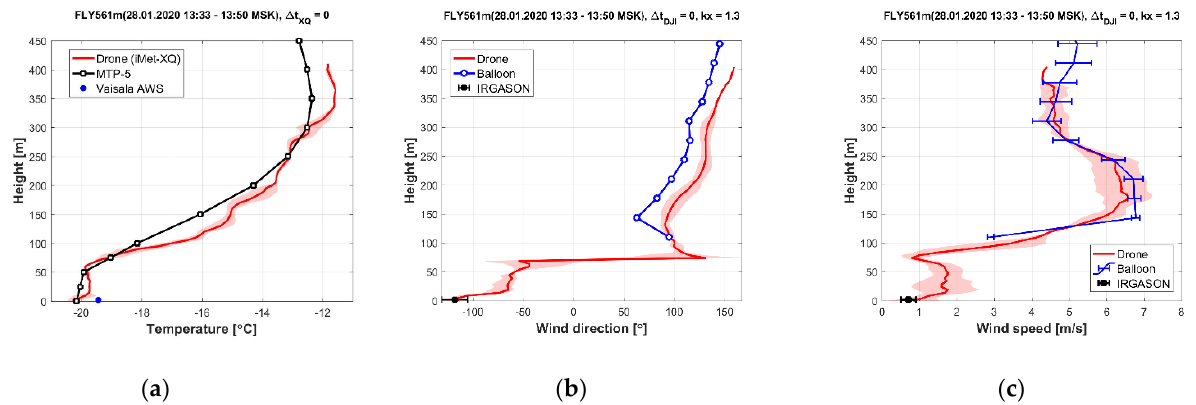
Figure 6. Vertical profiles of the air temperature ( a ), wind speed ( b ) and wind direction ( c ) according to drone-based sounding, balloon sounding and observations of MTP-5 temperature profiler for a case with a strong temperature inversion (28 January 2020). Designations are similar to Figure 5.